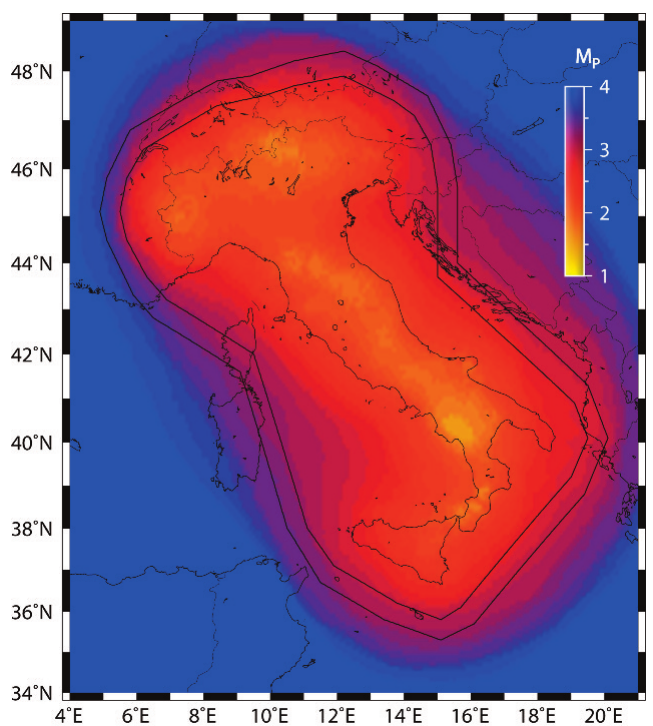
Figure 5. Probability-based magnitude of completeness map. The map was computed for January 1, 2008, for a probability level of 0.999. The black polygons indicate the testing (inner) and collection (outer) area.